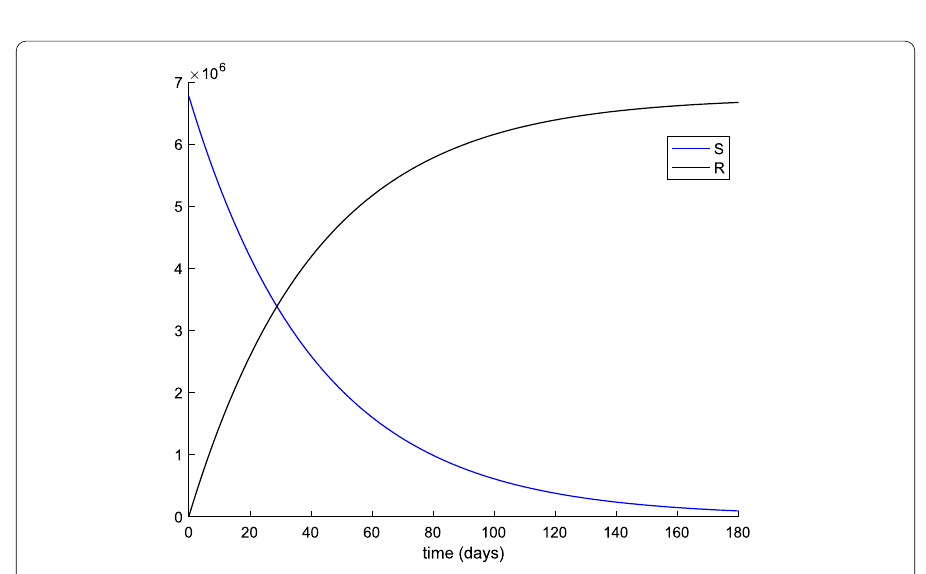
Figure 6 Evolution of susceptible and recovered when vaccination is applied and no treatment is used. The vaccination gain is set to k V = 0.001